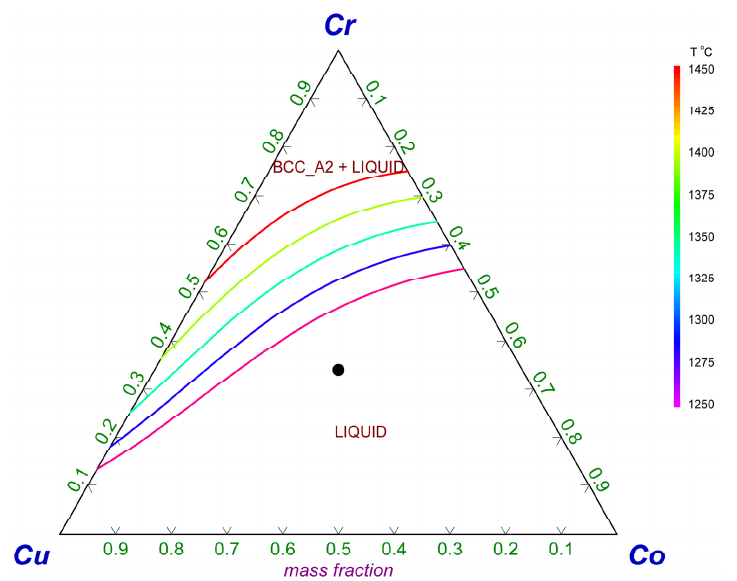
Figure 9. Cr-Cu-Co-22% Al liquidus projection diagram calculated in FactSage 7.3 [35].